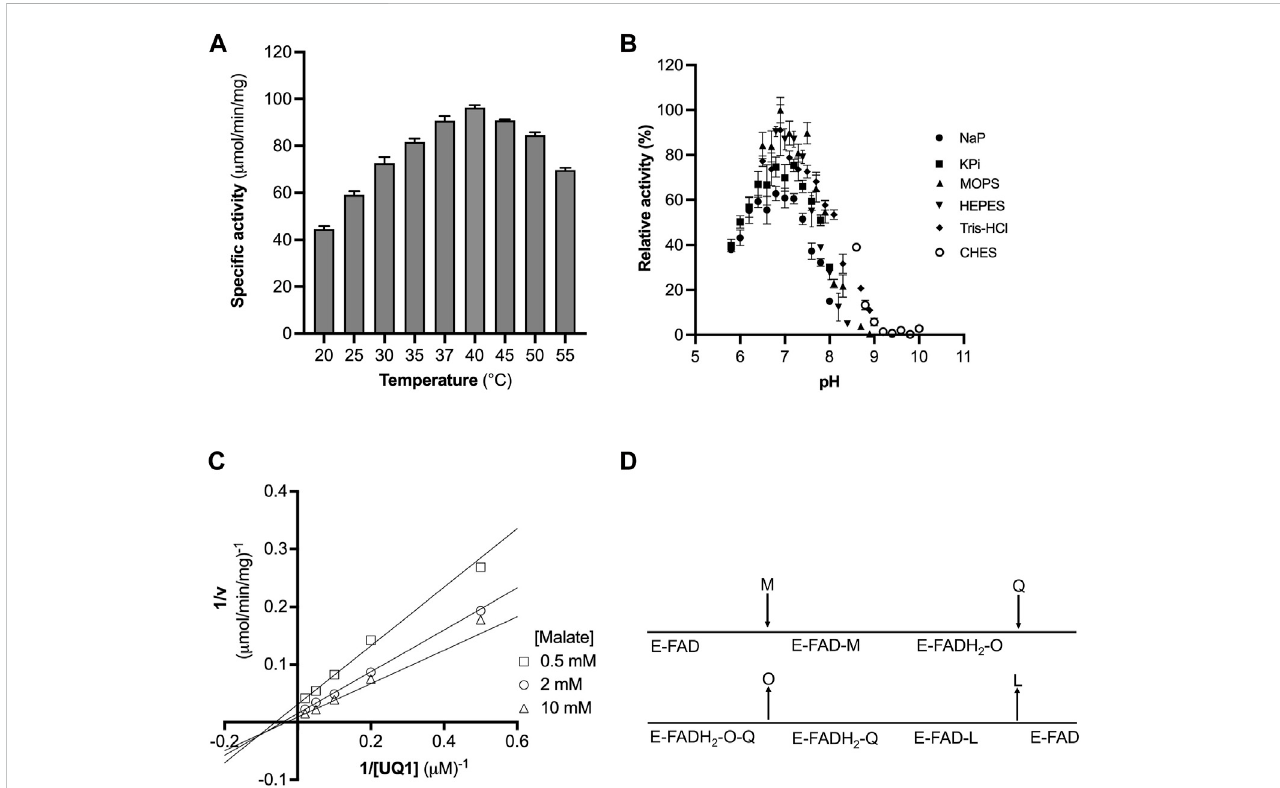
FIGURE 2 Optimization of CjMQO temperature and pH. (A) The optimal temperature of CjMQO was assayed spectrophotometrically. The enzymatic activity at each point was determined at varying temperatures and in triplicate. (B) The optimal buffer and pH conditions were determined using different buffers and pH values at 37 ° C; values represent the average of triplicate measurements. (C) Analysis of the kinetic mechanism of CjMQO using a double reciprocal plot. The activity of puri fi ed CjMQO was measured by varying UQ1 concentrations at fi xed malate concentrations (i.e., 0.5, 2, and 10 mM). The straight lines intersecting below the X-axis in the third quadrant indicate a bisubstrate sequential Bi-Bi reaction mechanism. (D) Schematic representation of the Bi-Bi reactionmechanisminwhichmalate(M)andquinone(Q)arethesubstratesoftheenzyme(E)andoxaloacetate(O)andquinol(L)aretheproducts.E-FADand E-FADH 2 represent the enzyme with bound FAD in its oxidized and reduced form,